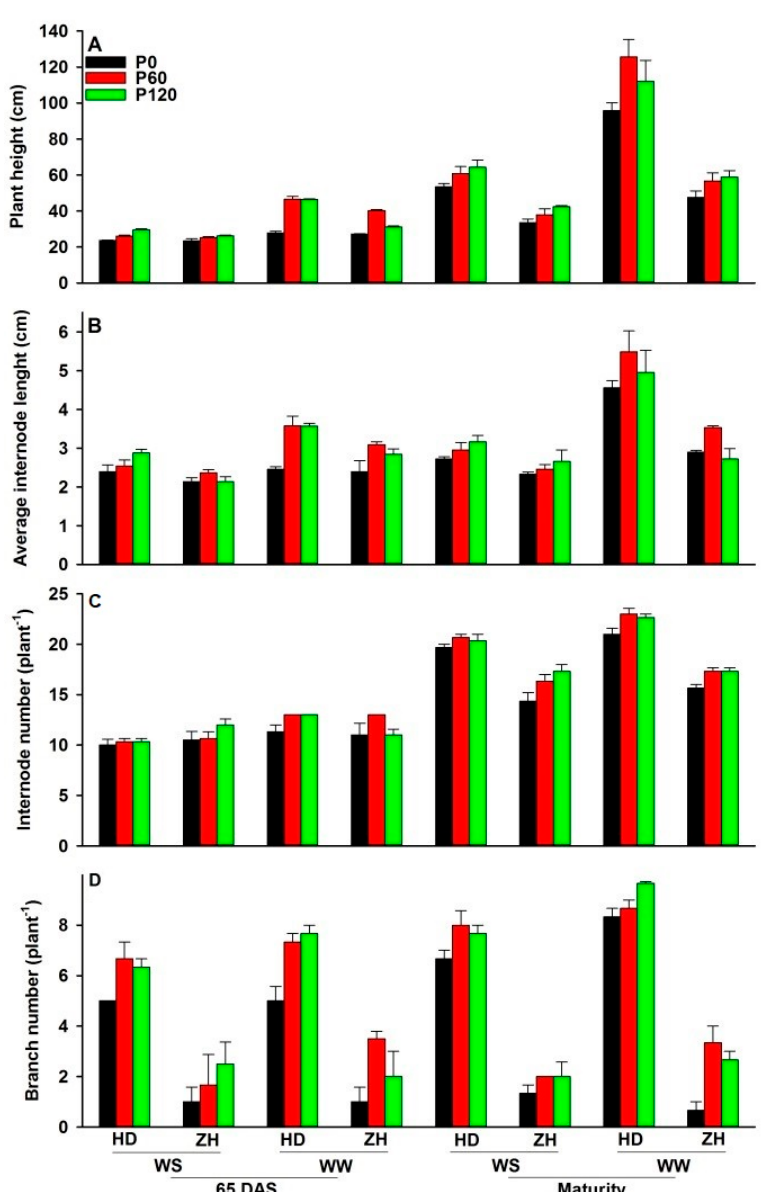
Figure 3. ( A ) Plant height, ( B ) average main stem internode length, ( C ) main stem internode number per plant and ( D ) branch number per plant at 65 days after sowing (DAS) and at maturity of soybean genotypes Huangsedadou (HD) and Zhonghuang 30 (ZH) with three levels of applied P (0 (P0), 60 (P60) and 120 (P120) mg P kg –1 dry soil) and two water treatments (well-watered (WW) and cyclic water stress (WS)). Values are means + one standard error of the mean ( n = 3).